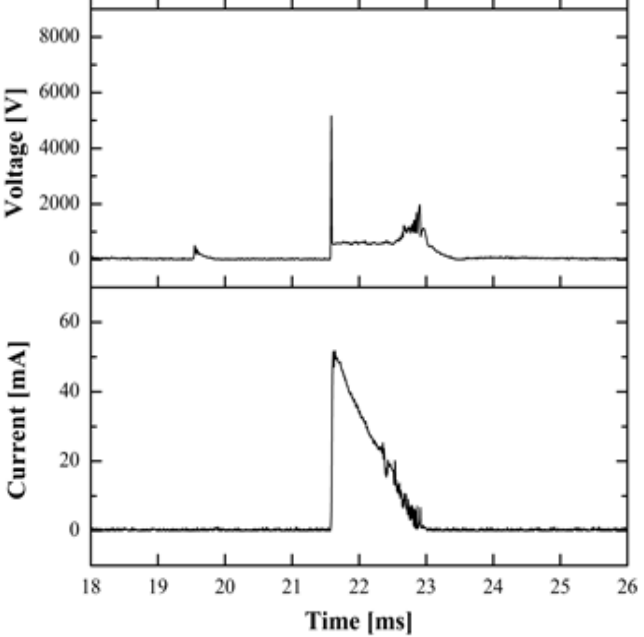
Figure 2. The current and the voltage waveforms for induction coil power supply (ICR).